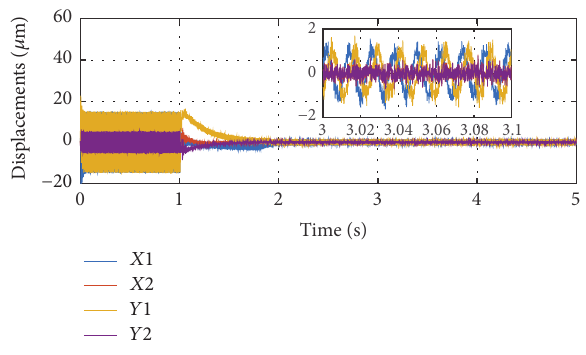
Figure 10: Shaft displacements in radial